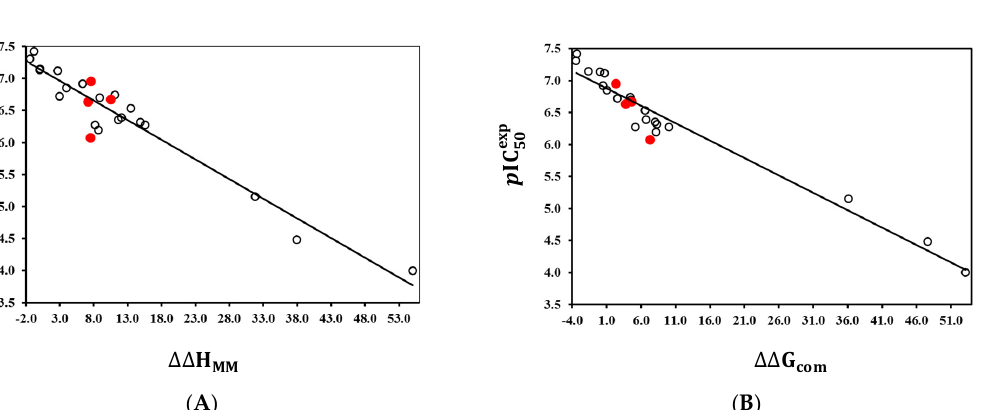
Figure 2. ( A ) graph of the correlation Equation (1) (Table 3) between 𝑝 IC (cid:2873)(cid:2868)(cid:2915)(cid:2934)(cid:2926) and relative enthalpic contribution ∆∆ H (cid:2897)(cid:2897) [kcal ∙ mol − 1 ] to the rGFE. ( B ) plot of the rGFE of the Pf ENR ‐ TCLs complex formation ∆∆ G (cid:2913)(cid:2925)(cid:2923) [kcal ∙ mol − 1 ] (Equation (2), Table 3) of the training and validation sets [21]. The data points from the validation set are shown in red.